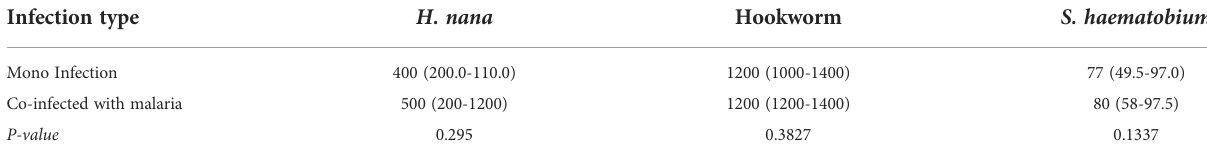
TABLE 1 Burden of helminths during mono- and co-infections with Plasmodium falciparum. Infection